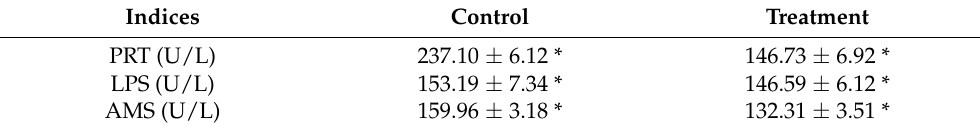
Table 7. Comparison of mid-intestinal digestive enzymes in A. schrenckii